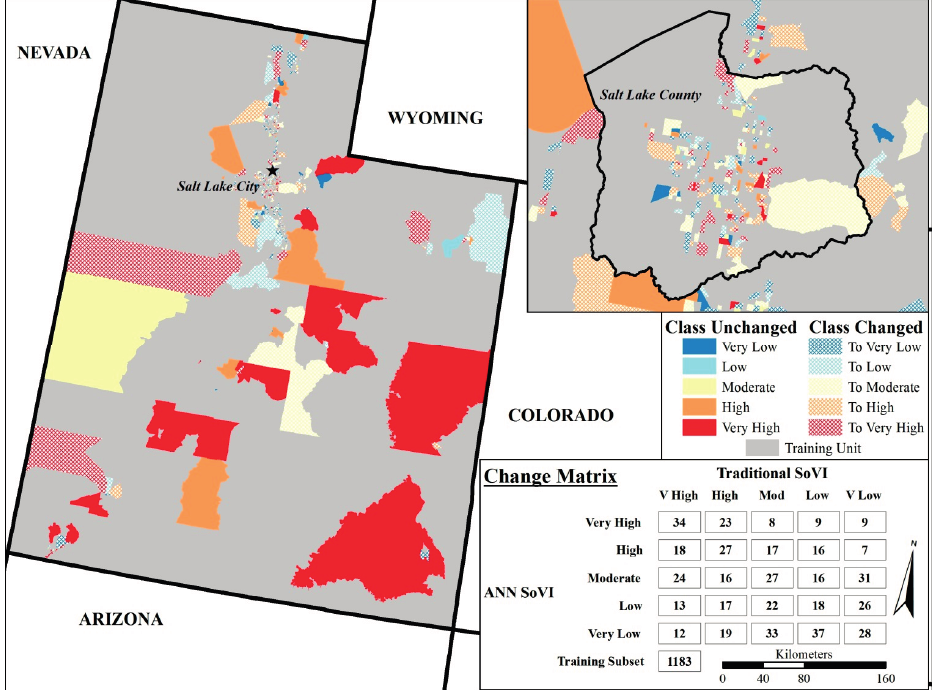
Figure 6. Comparison of the traditional SoVI classes and the ANN-extended SoVI classes for the state of Utah. The legend includes a change matrix showing how the traditional SoVI classified the census block groups against how the ANN-extended SoVI classified the same census block groups for the classification subset. The symbolized classes indicate census blocks that remained unchanged between methods as well as a generalized representation of which census block changed to each vulnerability class. An inset map of Salt Lake County is included to show the most densely populated portion of the study